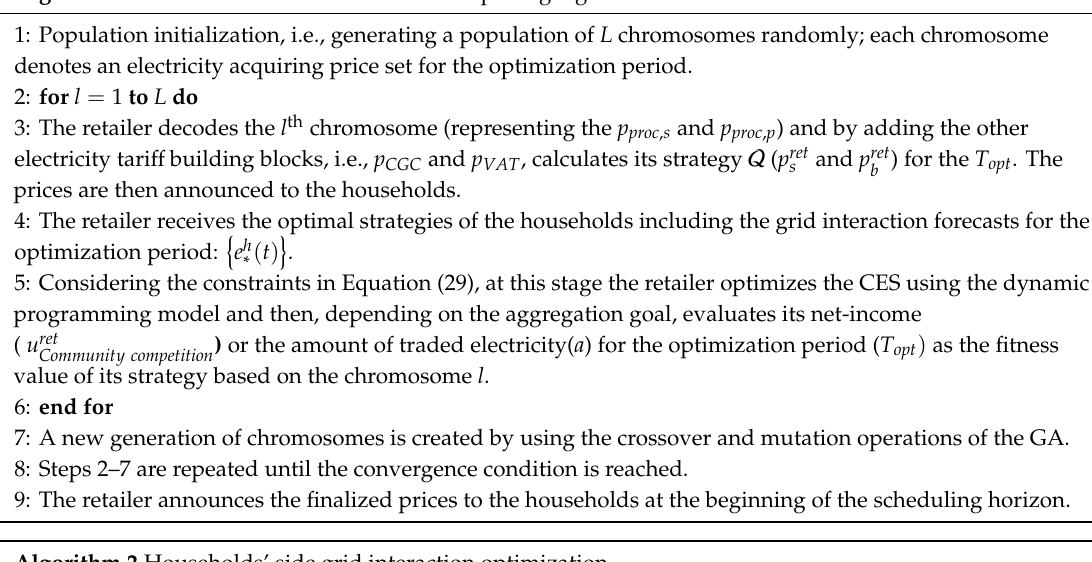
Algorithm 1 retailer’s side GA based real-time pricing algorithm